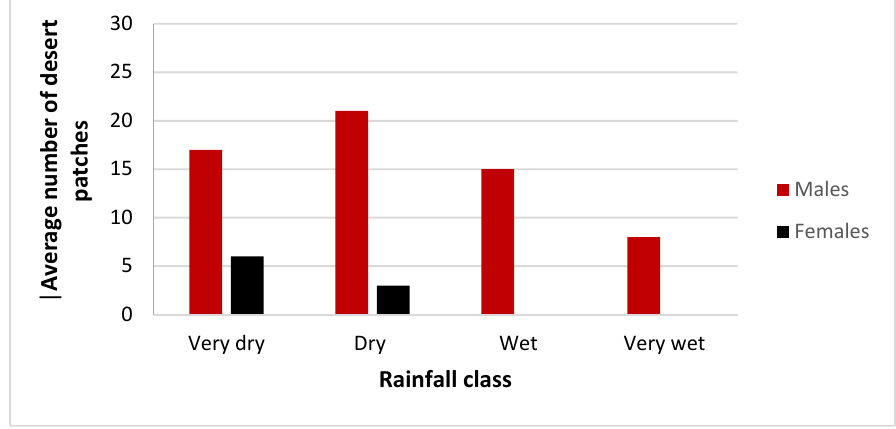
Figure 8. Prevalence of desertification among male and female grazing game players in UER (n female games = 22; n male games = 22).